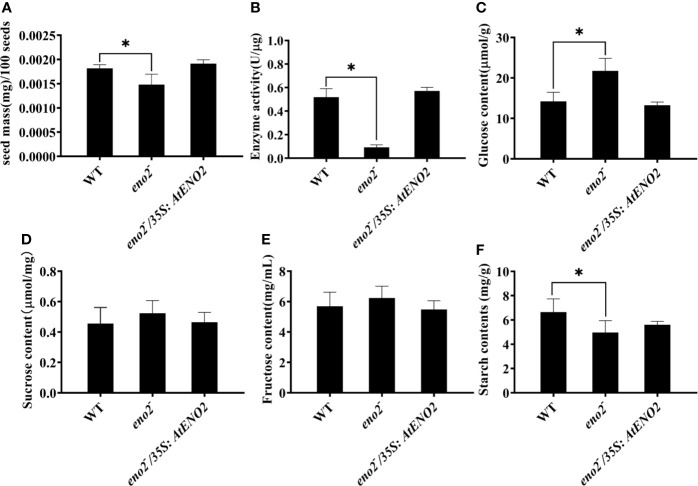
AtENO2 affects (A) the seed weight, (B) enolase activity and contents of secondary metabolite [(C) glucose; (D) sucrose; (E) fructose; (F) starch]. The values of the bars are means of three biological replicates with three technical repeats in each biological experiment. The asterisk (*) indicates the significant differences compared to WT (P<0.05).